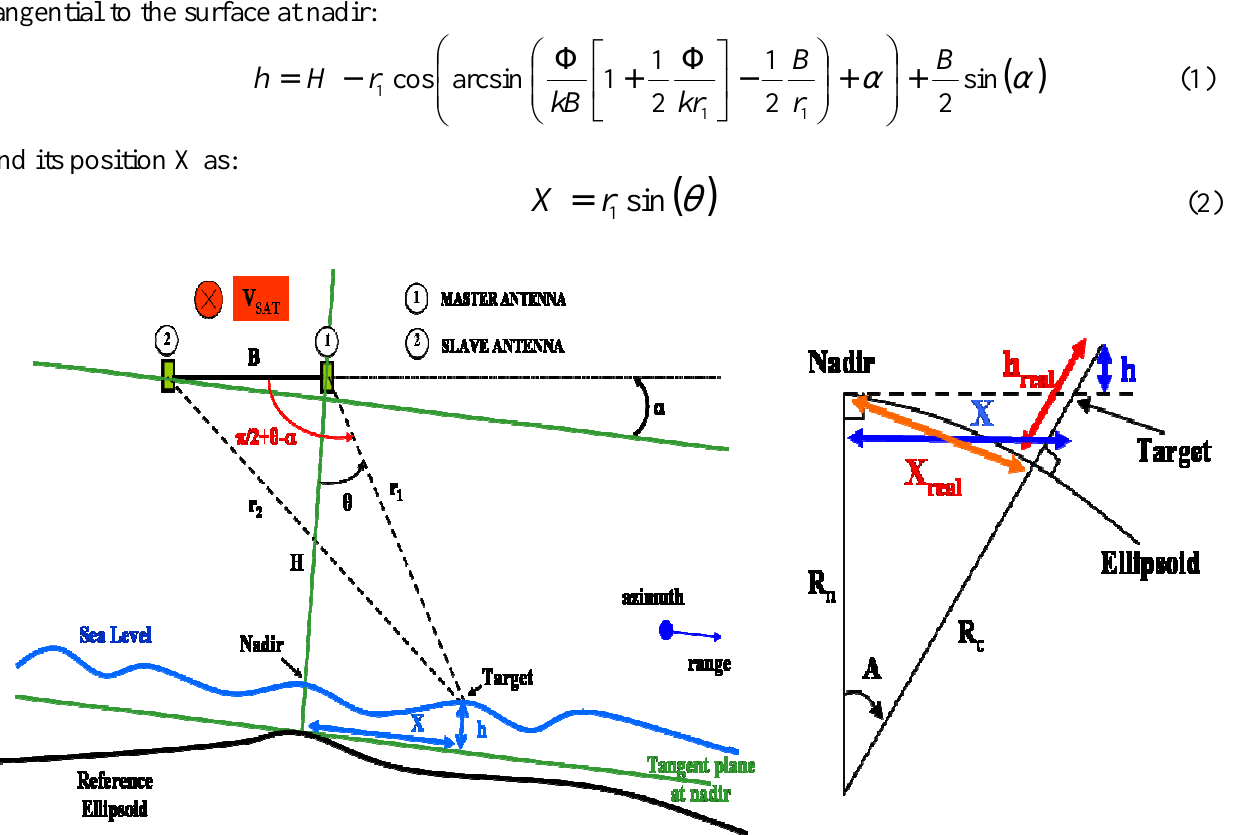
Figure 2. (a) Geometry of the interferometric measurement (b) Local Frame